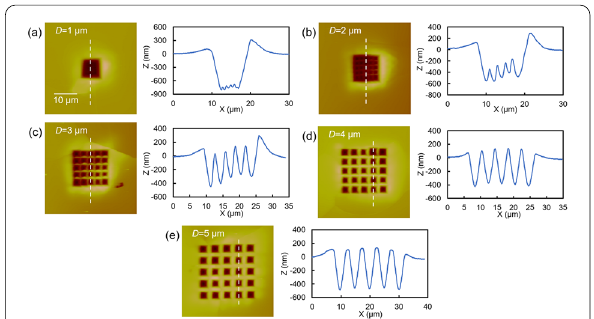
Figure 20 AFM images and the corresponding cross-sections of the experimental results for the 5 5 indentation arrays with the rotation × angle of 45° and the spacings of a 1 μm, b 2 μm, c 3 μm, d 4 μm and e 5